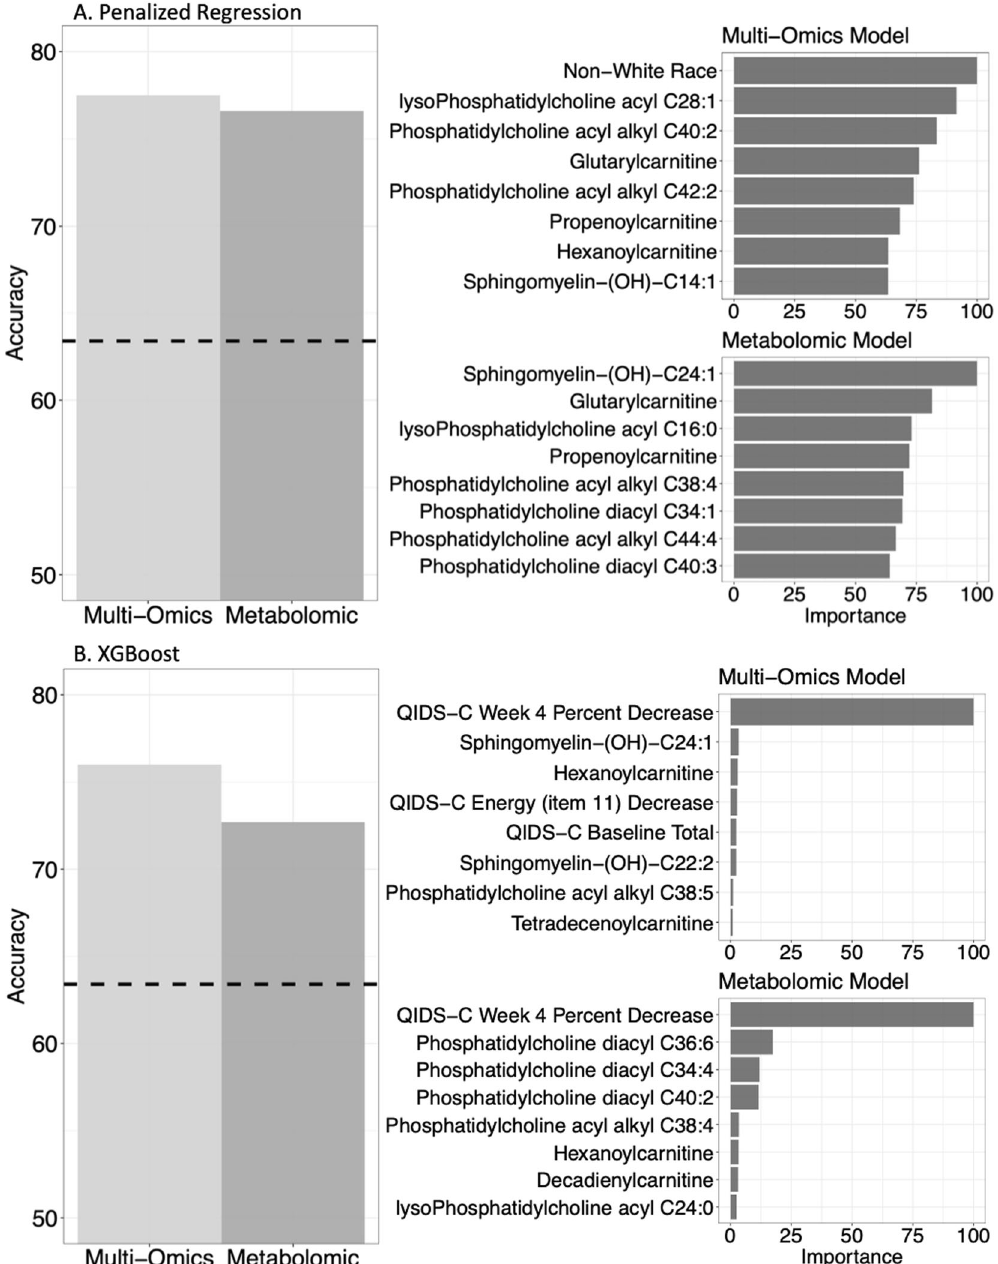
Fig. 2 Comparison of test-set accuracies for metabolomic and multi-omics models, with variable importance. Dashed line: null information rate (NIR). The NIR represents the response rate of 63.4% at 8 weeks of therapy. This serves as a benchmark to assess the signi fi cance of prediction